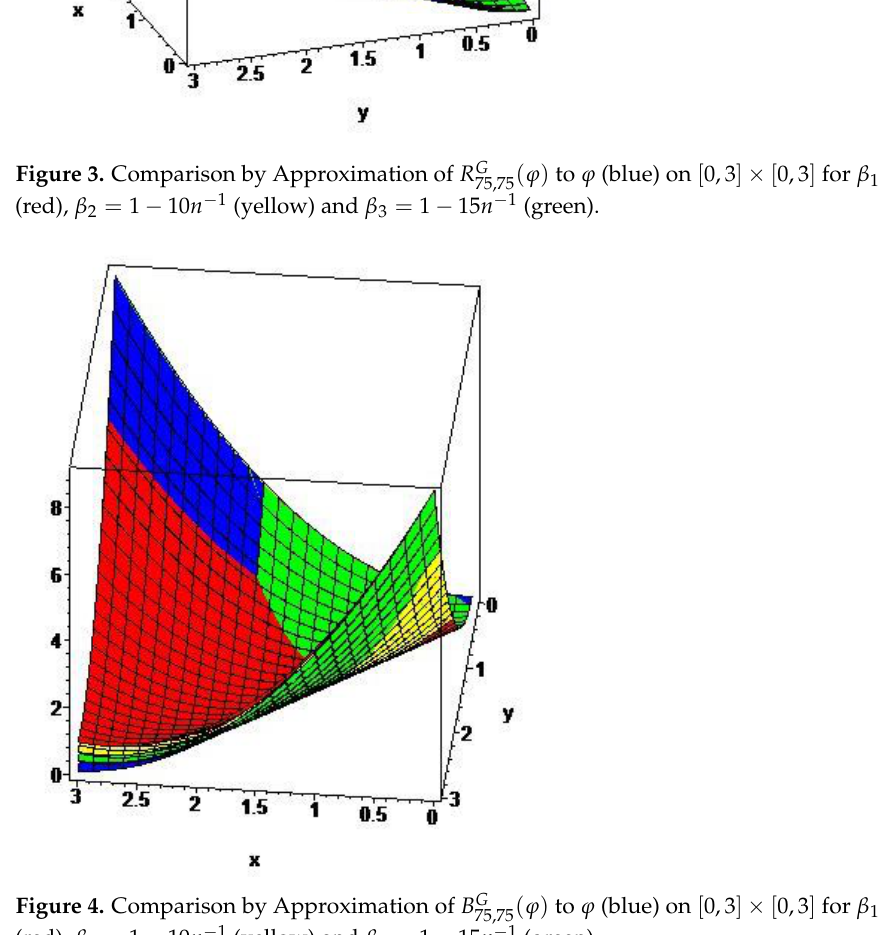
Figure 4. Comparison by Approximation of B G (red), β 2 = 1 − 10 n − 1 (yellow) and β 3 = 1 − 15 n − 1